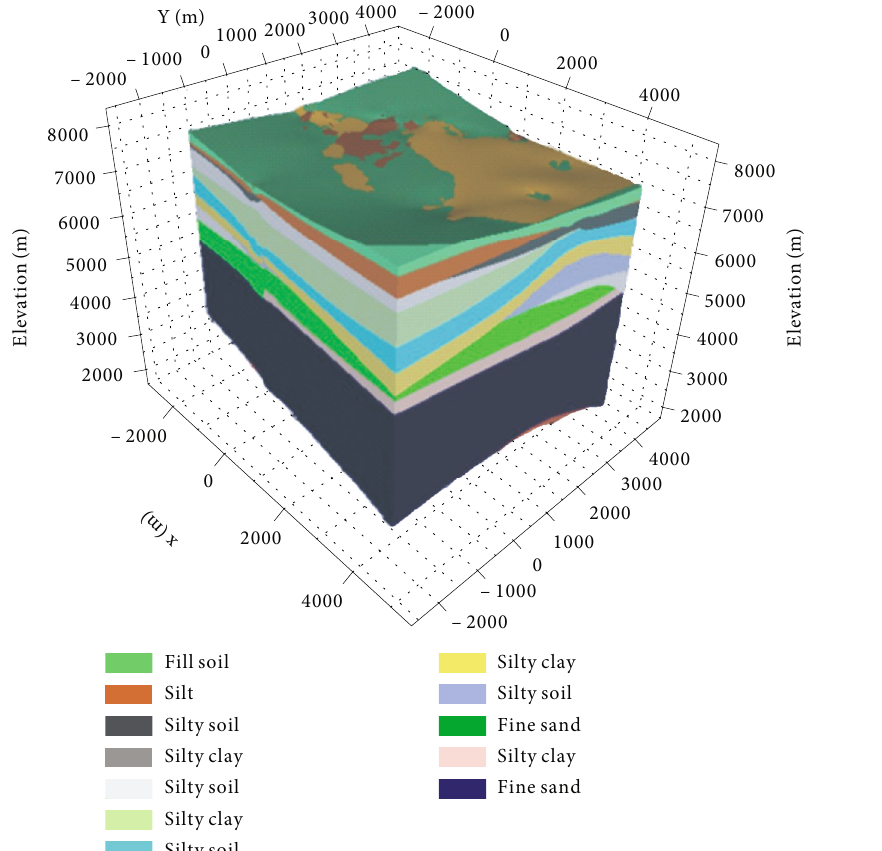
Figure 7: 3D geological